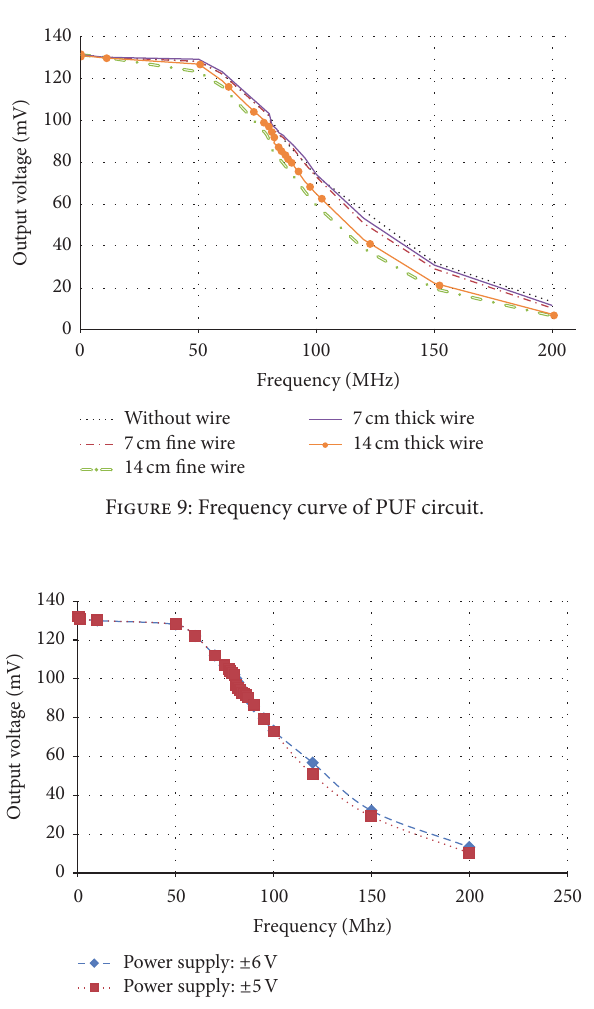
Figure 10: IM-PUF with different power supply.